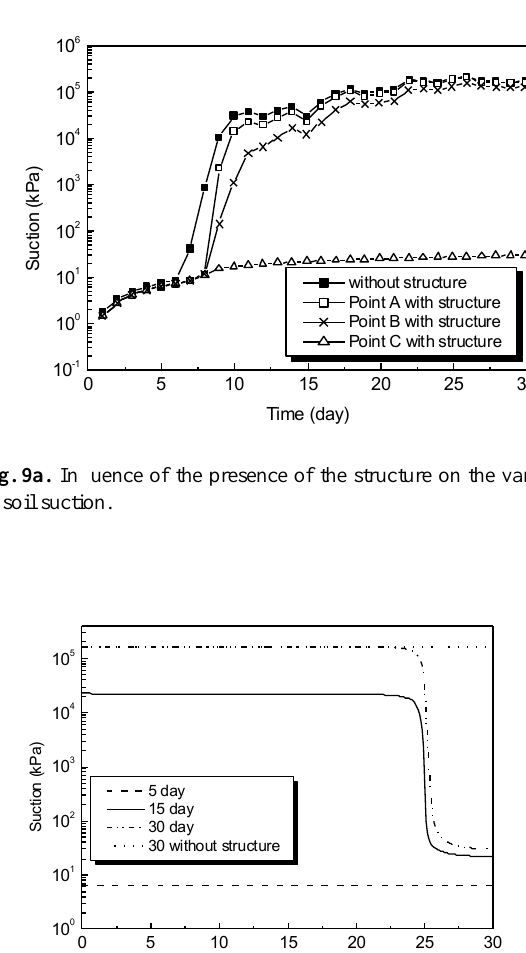
Figure 9b. Influence of the presence of the structure on the variation of the soil suction.